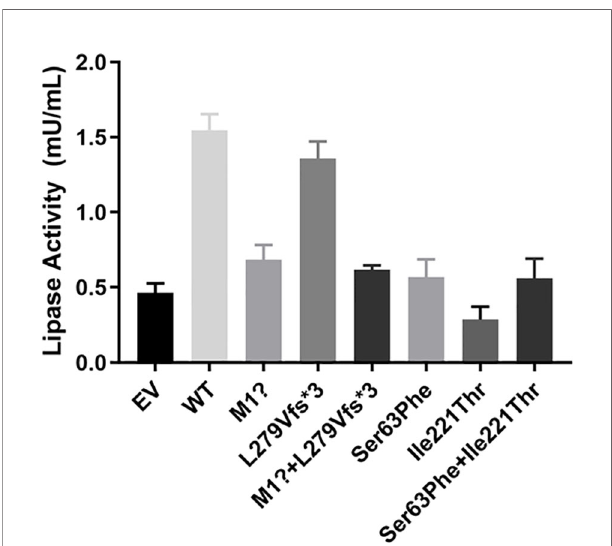
FIGURE 6 | Functional analysis of LPL mutants in the medium. Except for the p. L279Vfs*3 mutation, LPL activity in the medium transfected with other plasmids containing pcDNA3.1- LPL -MU was signi fi cantly reduced compared with the wild type. Speci fi cally, cells transfected with the p. M1? or the two variants (p. M1? and p. L279Vfs*3) showed reductions in protein activity of approximately 55.93 ± 3.28% (p<0.01) or 59.84 ± 4.47% (p<0.01), while LPL activity was reduced by 62.76 ± 9.90% (p<0.01) or 63.25 ± 10.55% (p<0.01) in the media of HEK 293T/17 cells transfected with p. Ser63Phe or the two variants (p. Ser63Phe and Ser63Phe+Ile221Thr). The media of cells transfected with p. Ile221Thr demonstrated a maximum reduction in LPL activity of approximately 81.56 ± 4.35%